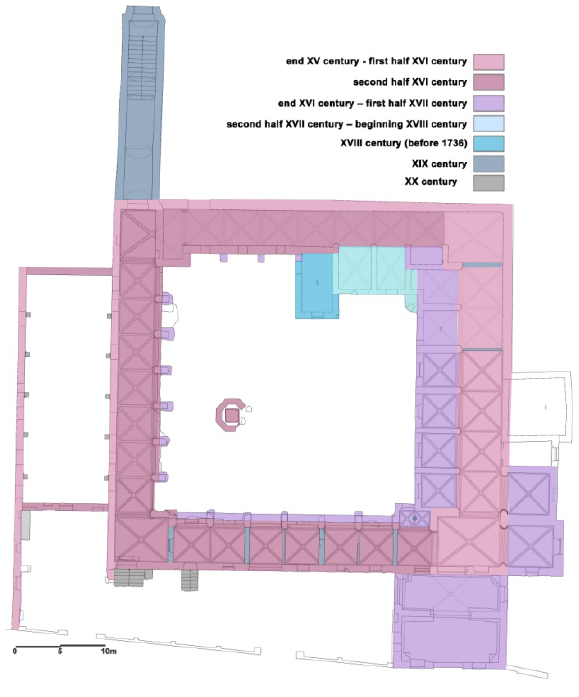
Figure 11: Dating hypothesis of the